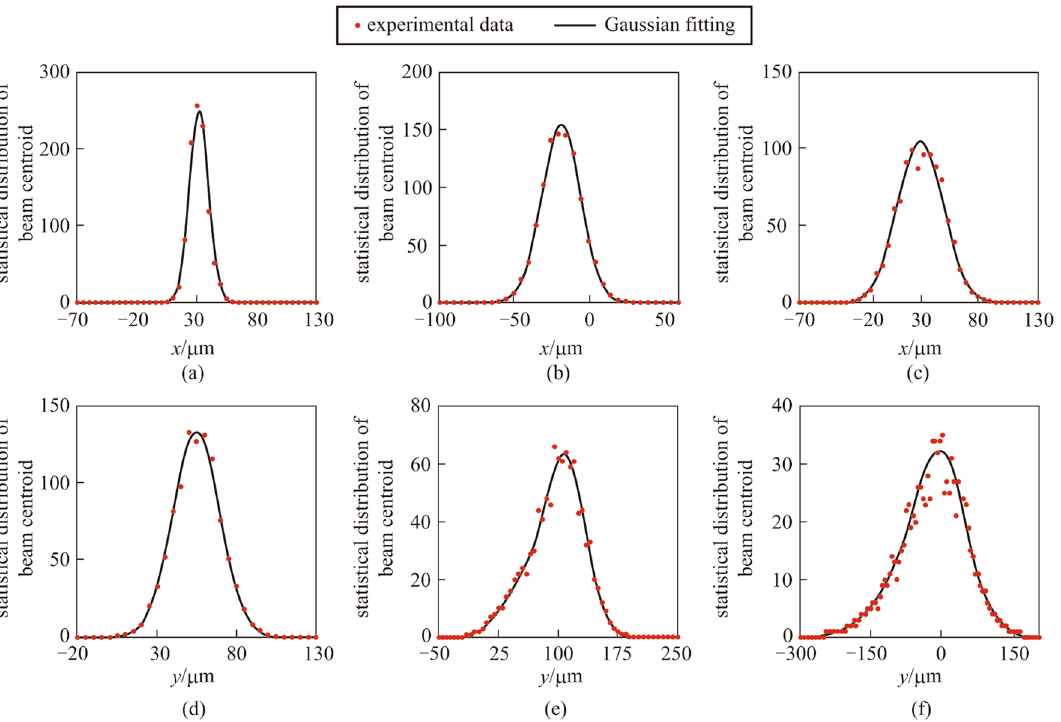
Fig. 4 Statistical distribution of beam centroid with Gaussian fitting for the distorted beam. a – c The beam centroid distribution in the horizontal direction at water depth of 12, 8, and 4 mm respectively. d – f The beam centroid distribution in the vertical direction at water depth of 12, 8, and 4 mm